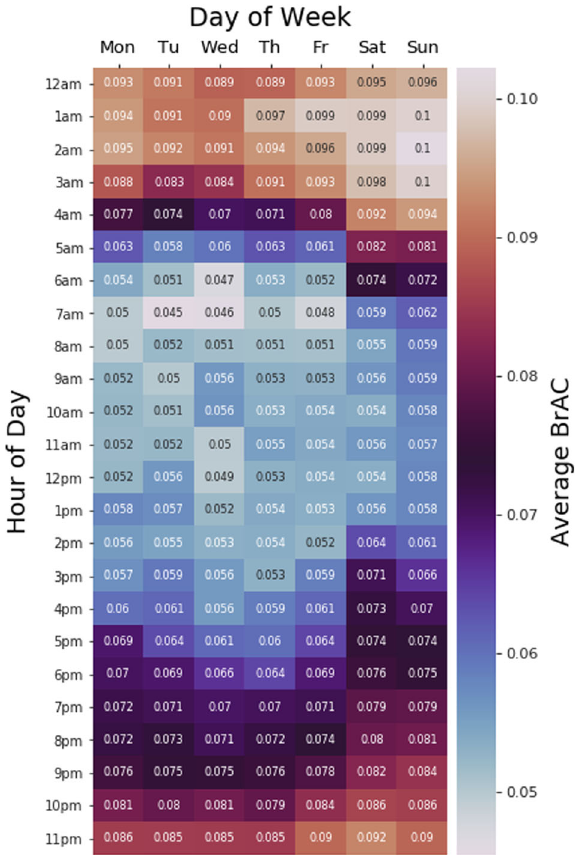
Fig. 4 Heat map characterization of BrAC levels by the hour of day and day of the week. The value in each square of the heat map represents the average BrAC level (g/dL) measured across all observations taken during that hour and day of the week, such that white is the highest, red and orange indicate values that exceed the legal limit, and blue values are below the threshold of